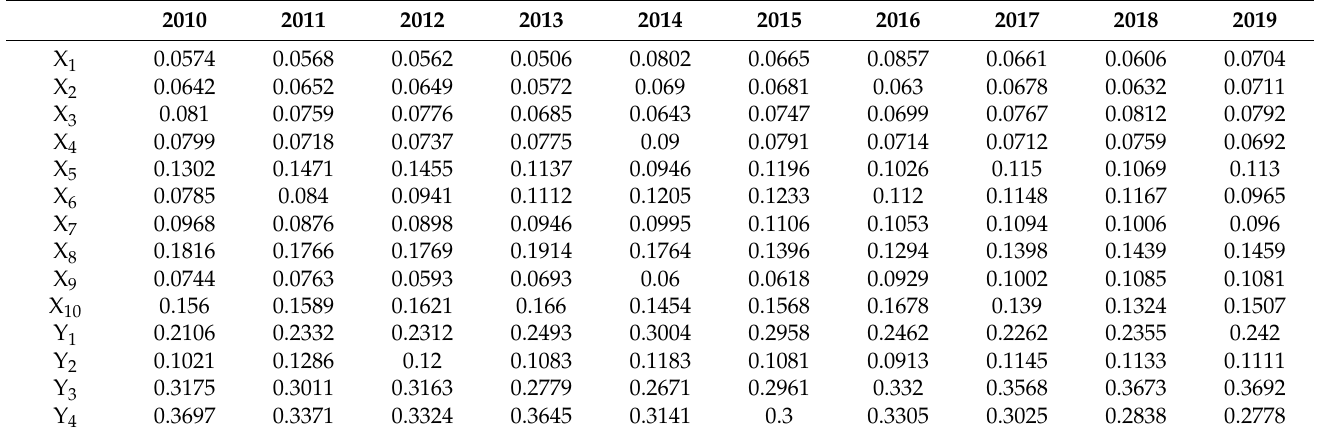
Table A1. Index weight in the elderly care service resource supply/demand system from 2010 to 2019 (actual data).